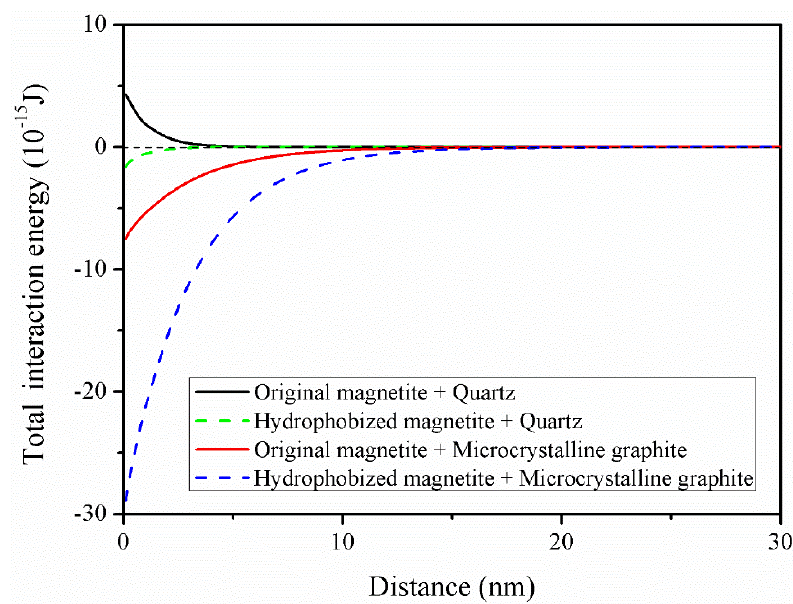
Figure 8. The total interaction energy between seeds and minerals as a function of h.